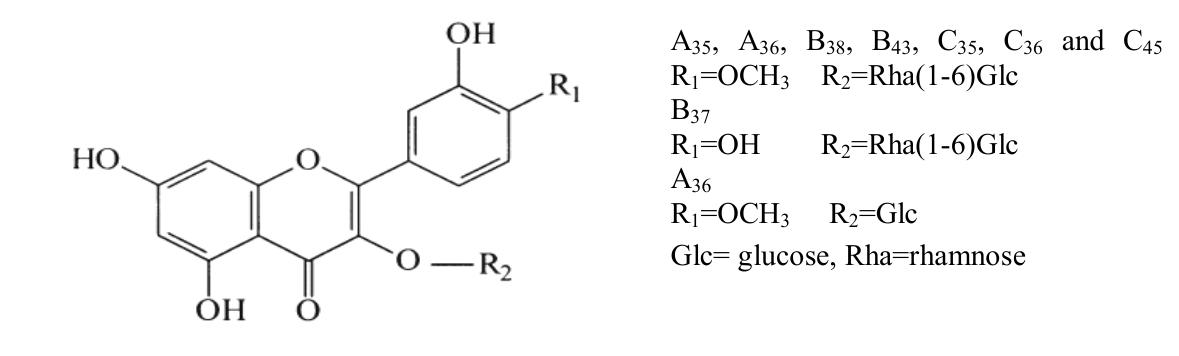
Figure 3. Chemical structures of flavonol glycosides found in methanol extract fruits of Tunisian O. ficus indica and O. stricta